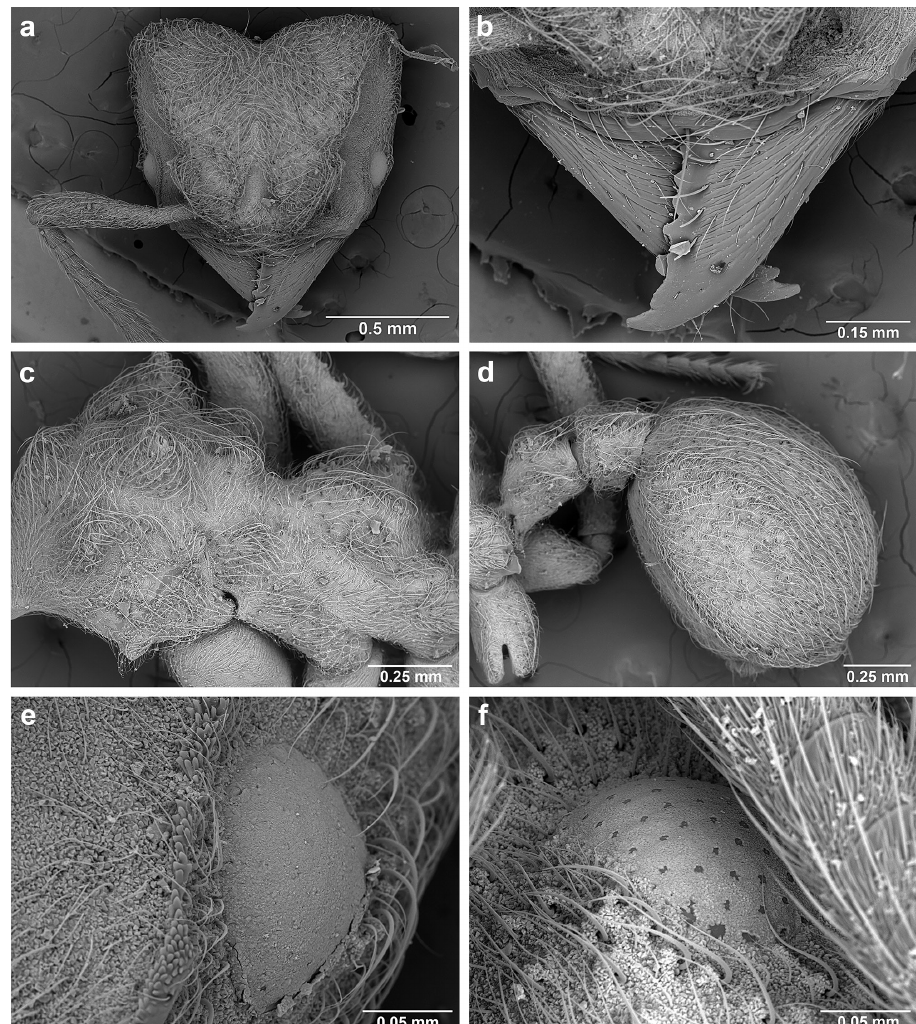
Figure 57. S. saussurei worker (USNMENT01126237), SEM images. a Head, full-face view b mandibles c mesosoma, lateral view d metasoma, lateral view e eyes completely covered with white layer, individual ommatidia not visible f eyes with thick white layer, ommatidia visible through small holes in the layer.